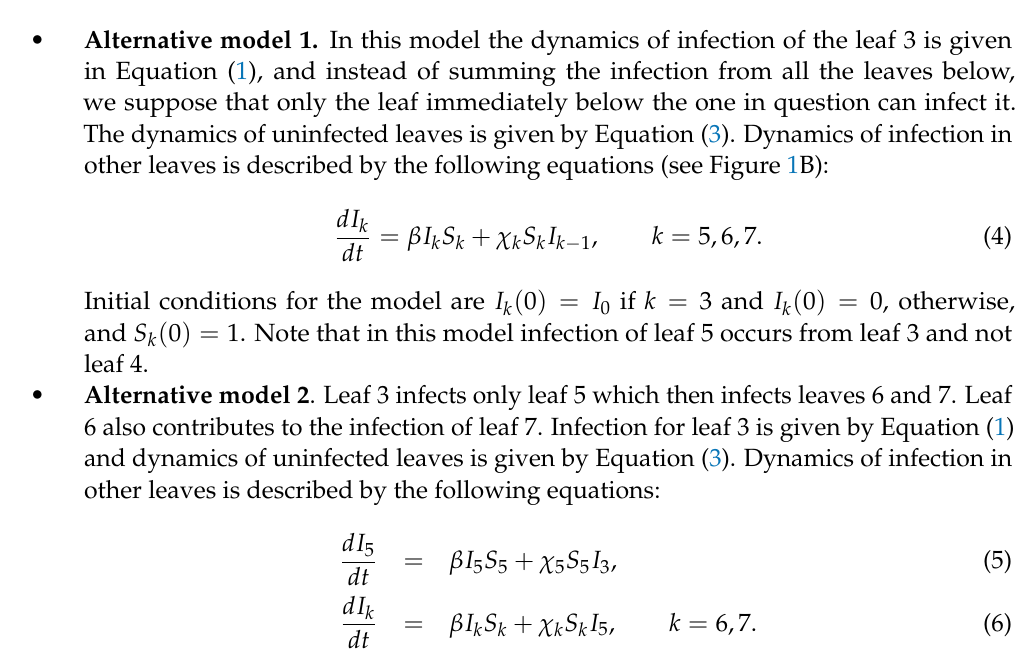
Figure 1. Examples of several alternative mathematical models of virus spread in plants analyzed in this paper. In experiments of Tromas et al. [14], two different viruses (“Venus” and “BFP”) were rubbed into leaf 3 and the fraction of infected leaf cells (protoplasts) was followed by flow cytometry over time (see Section 2 for more detail). In schematics, S k and I k denote the fraction of uninfected and infected cells in the k th leaf, respectively, and the syringe indicates the primary place where infection started in the model. Arrows denote the process of leaf infection (at a rate β ) and transmission of infection between leaves (at a rate χ ). In the original Tromas et al. [14] model (( A ), Equations (1)–(3)), infection starts at leaf 3 and is then transported to other leaves at a rate proportional to the total fraction of infected cells in leaves below. In alternative model 1, infection starts with leaf 3 but upper leaves are only infected by the leaves just below them (( B ), Equation (4)). In alternative model 4, infection starts in leaf 5 and then proceeds to leaves above or below leaf 5 similar to the alternative model 1 (( C ), Equation (11)). Finally, in the alternative model 7 infection starts at the upper leaf 7 and proceeds to lower leaves in a manner similar to the original Tromas et al. [14] model (( D ), Equation (15)). Other alternative models are described in the Section